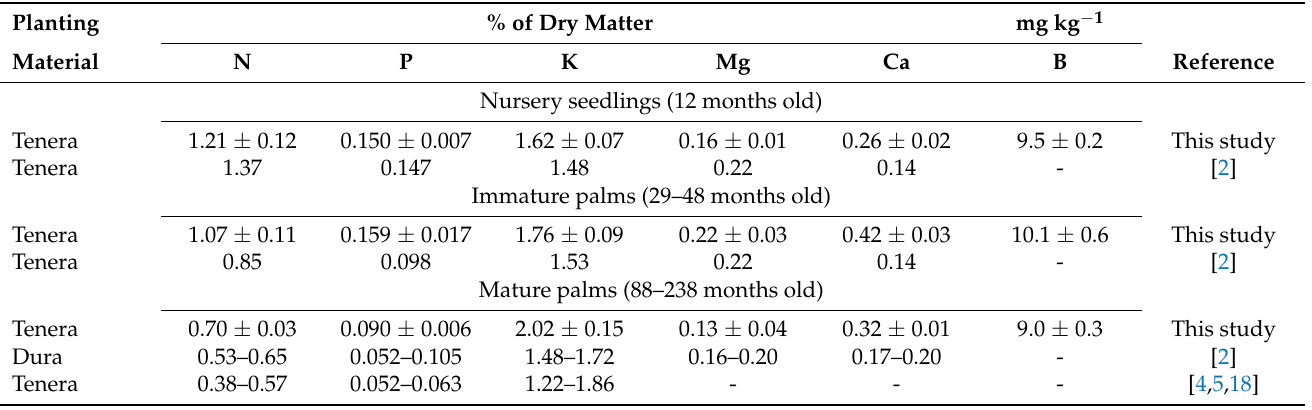
Table 6. Concentrations (mean ± SE) of N, P, K, Mg, Ca, and B of nursery, immature, and mature oil palms. Other studies did not report their SE